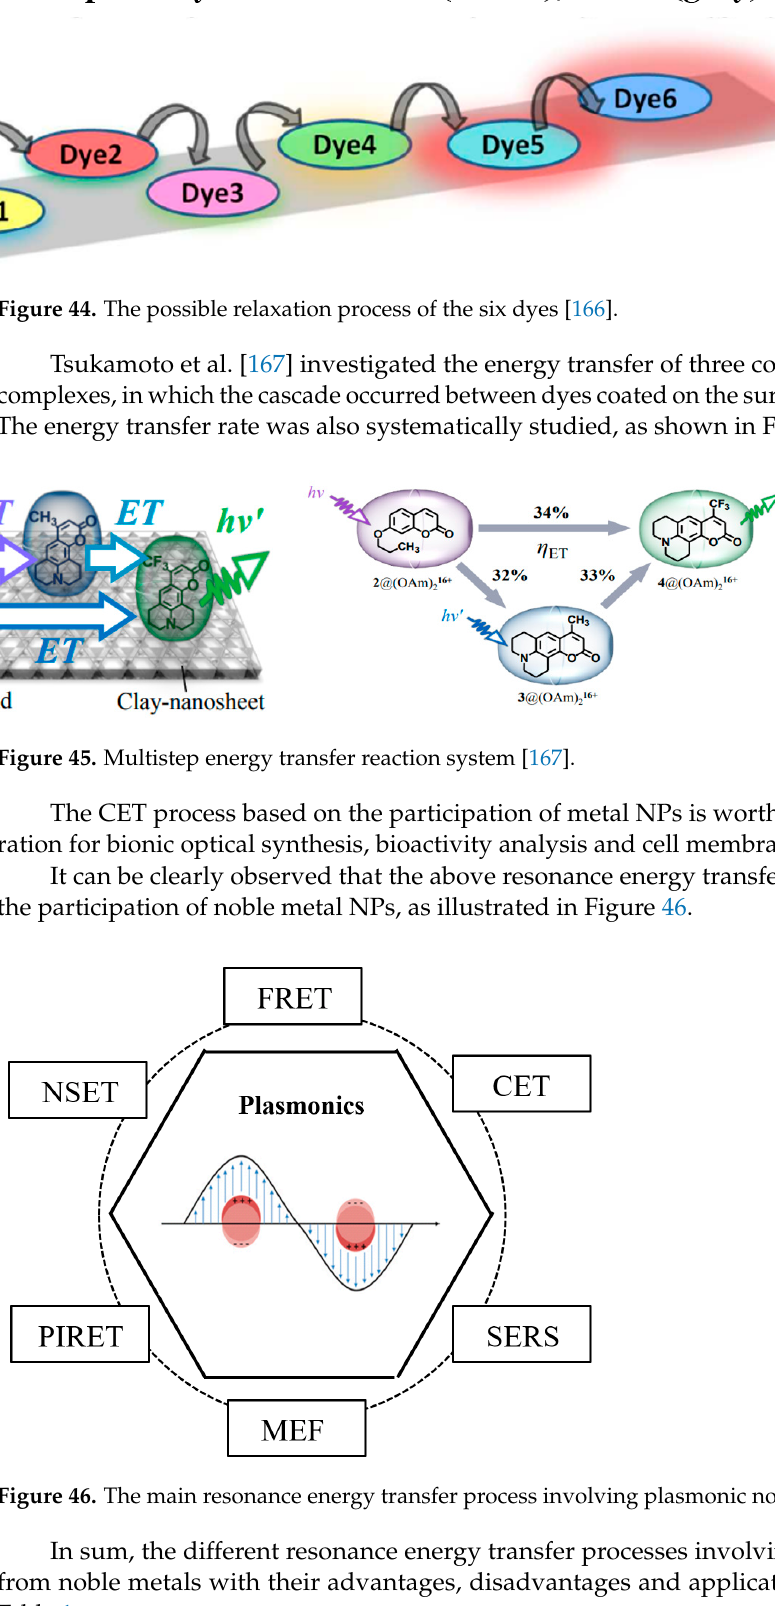
Table 1. Di ff erent resonance energy transfer processes involving plasmonic noble metal NPs with advantages, disadvantages and applications.